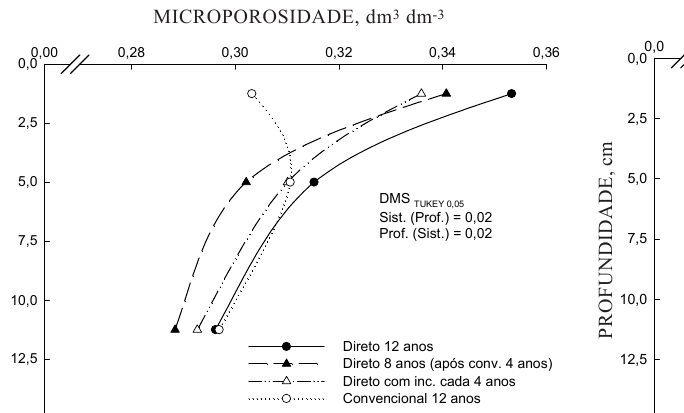
ÍNDICE DE ESTABILIDADE DE AGREGADOS DMPu/DMPs